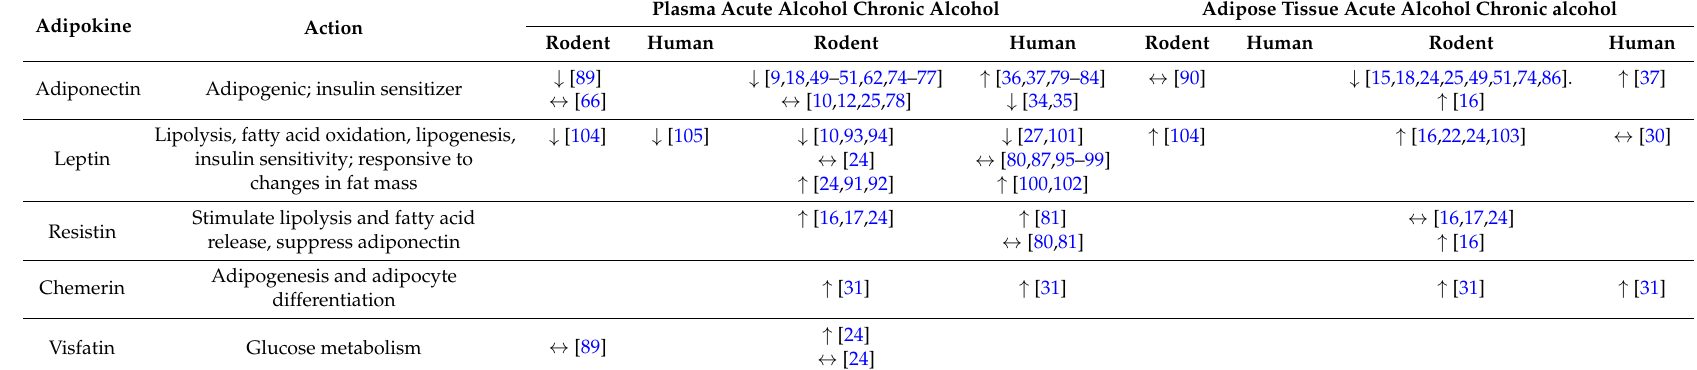
Table 1. Modulation of adipokines by alcohol. The effects of either acute or chronic alcohol on circulating adipokine levels or expression within adipose tissue are listed below along with the general physiological action of the given adipokine. Note that the given action may or may not have been confirmed to occur following alcohol. Arrows indicate the direction of change reported under the given